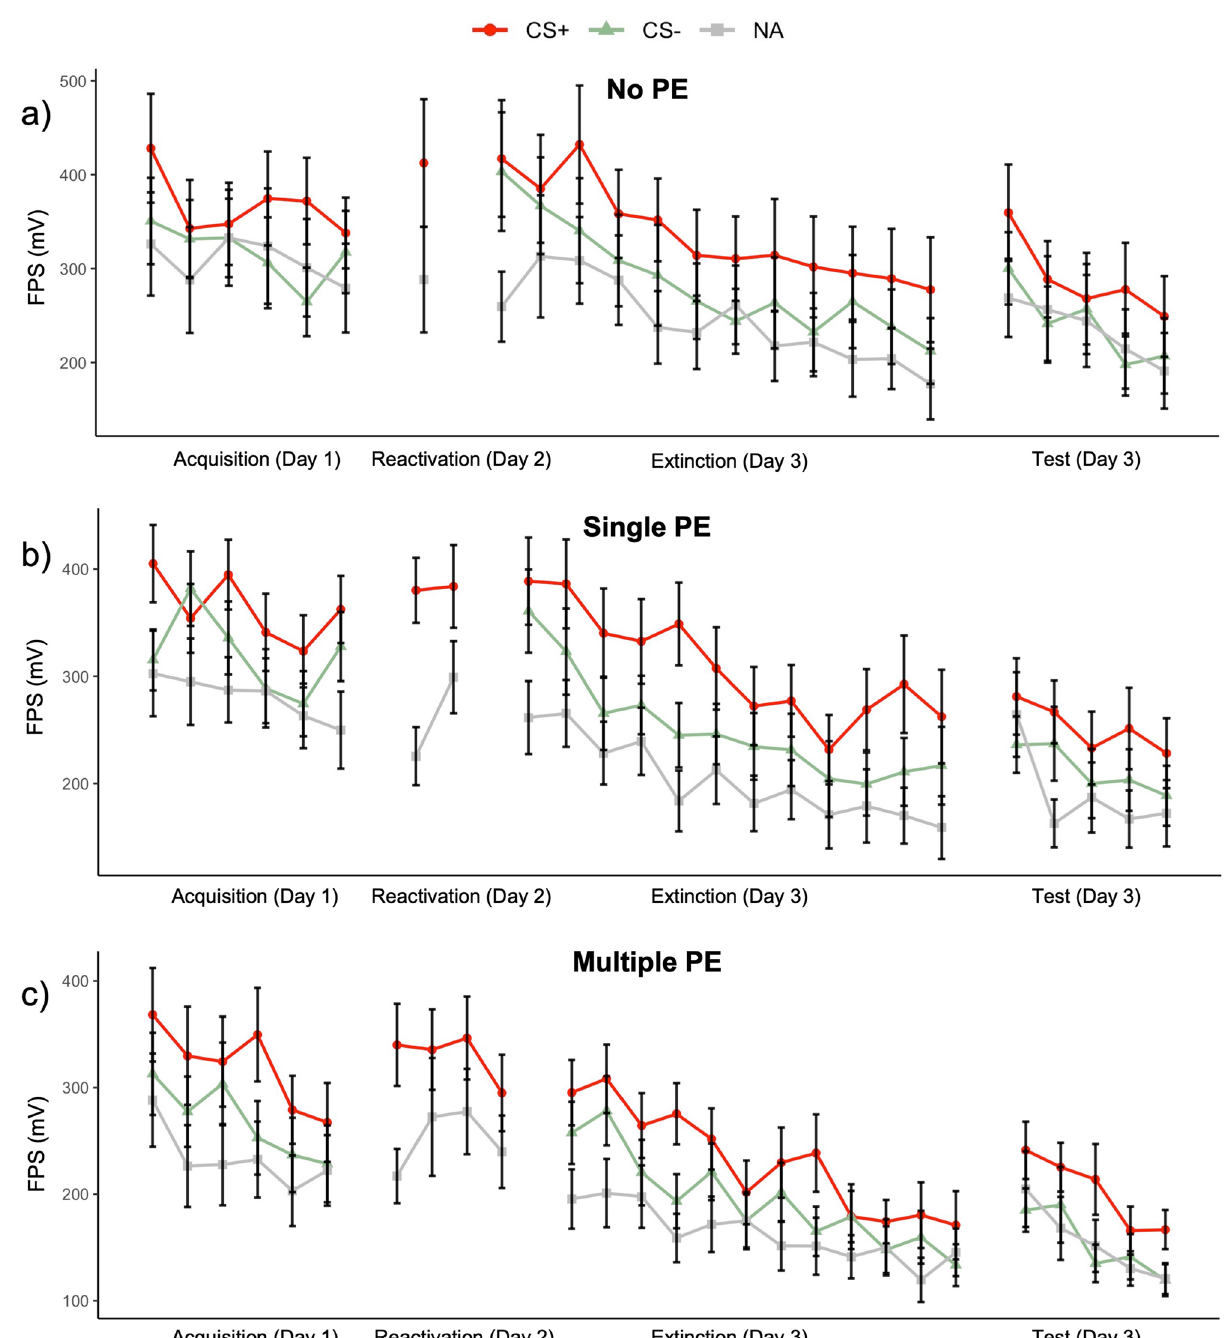
Figure 2. Mean fear-potentiated startle response to the CS +, CS−, and noise alone per trial in ( a ) the no PE group (n = 30), ( b ) the single PE group (n = 31), and ( c ) the multiple PE groups (n = 30). There were no significant differences in acquisition and reactivation between the groups. Against our expectations, the groups did not significantly differ on the first extinction and the first reinstatement test trial either. Error bars represent one standard error of the